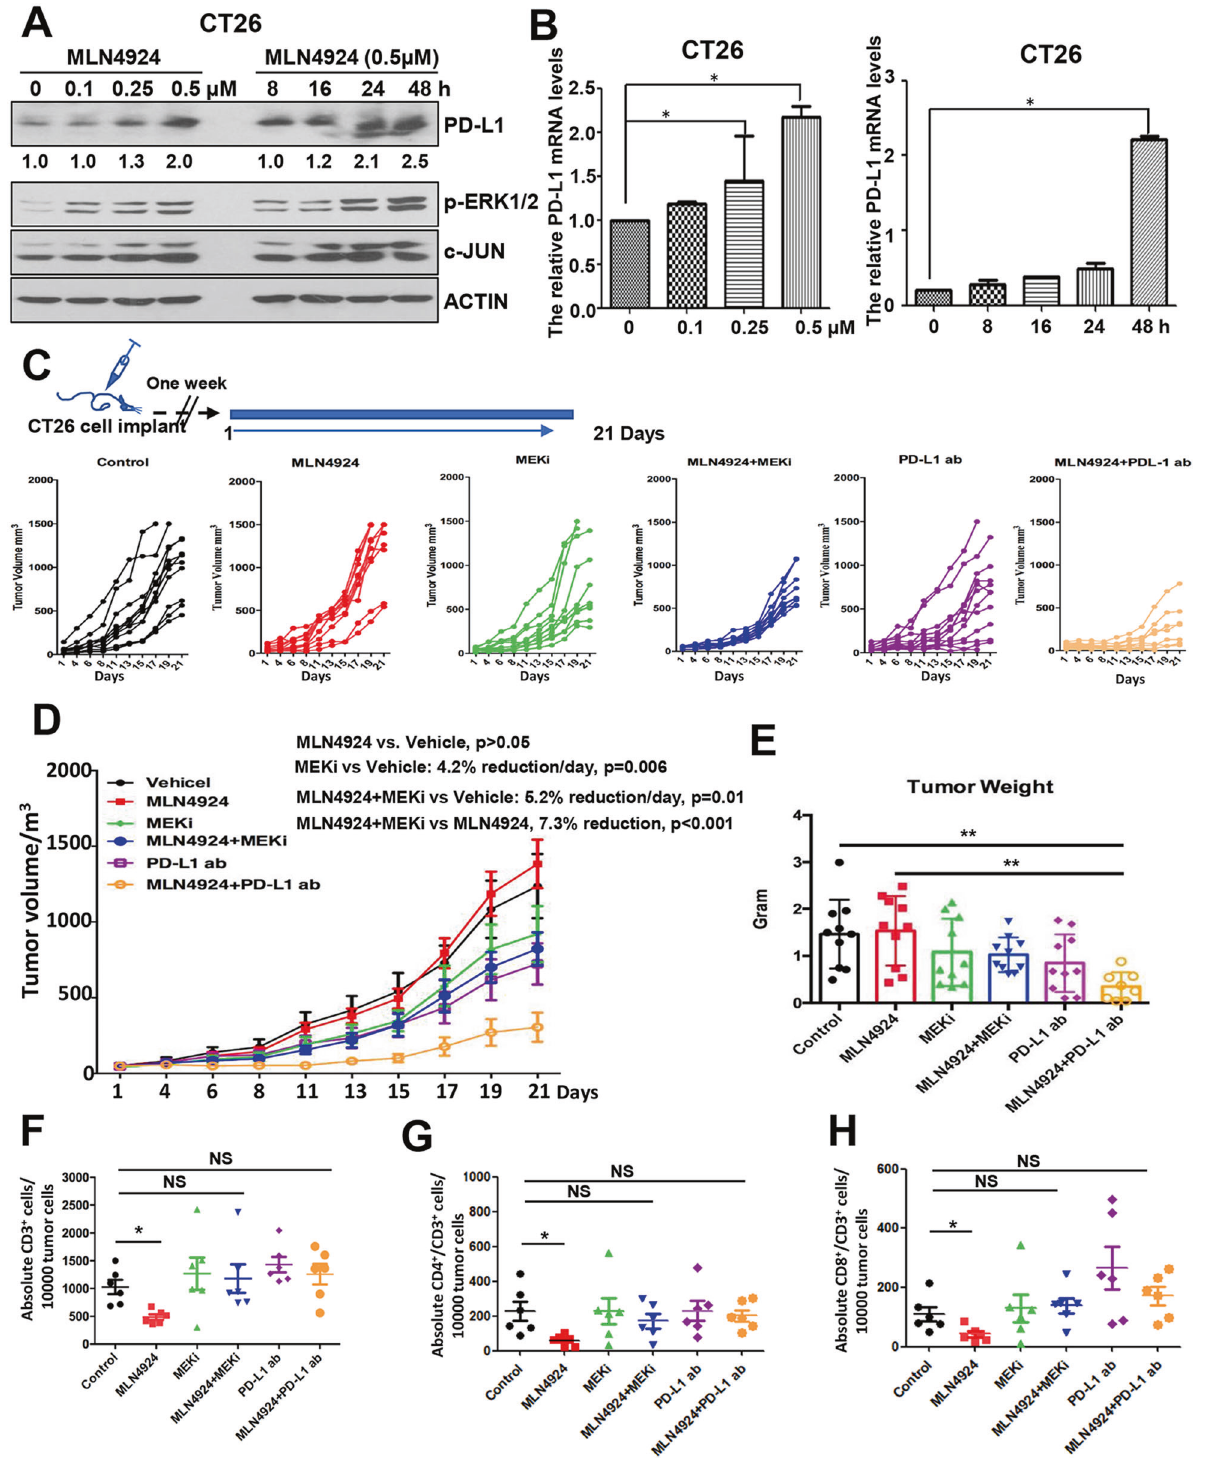
Fig. 6 Enhanced tumor suppression by combination MLN4924 with MEK inhibitor or anti-PD-L1 antibody in xenograft tumor model. A , B MLN4924 treatment increases PD-L1 mRNA and protein levels in dose- and time-dependent manners. CT26 cells were treated with various concentrations of MLN4924 for indicated time periods, followed by IB and qRT-PCR analysis. C , D Tumor growth rate. Top: drug treatment regimen. Bottom: tumor growth rate after 6 indicated treatments (Control, MLN4924, MEKi, PD-L1 ab, MLN4924 + MEKi, MLN4924 + PD-L1 ab) at each individual ( C ) or group level ( D ). E The weight of tumors after harvesting at the end of experiment. F – H FACS pro fi ling of tumor in fi ltrated T-cell population: Single cell suspension of tumor mass was prepared from each treatment group, and subjected to FACS pro fi ling with indicated Abs. The data were quanti fi ed and statistically analyzed. MEKi MEK inhibitor (trametinib), PD-L1 ab anti-PD-L1 antibody; p < 0.05 (*), p < 0.01 (**); NS not signi fi cant.